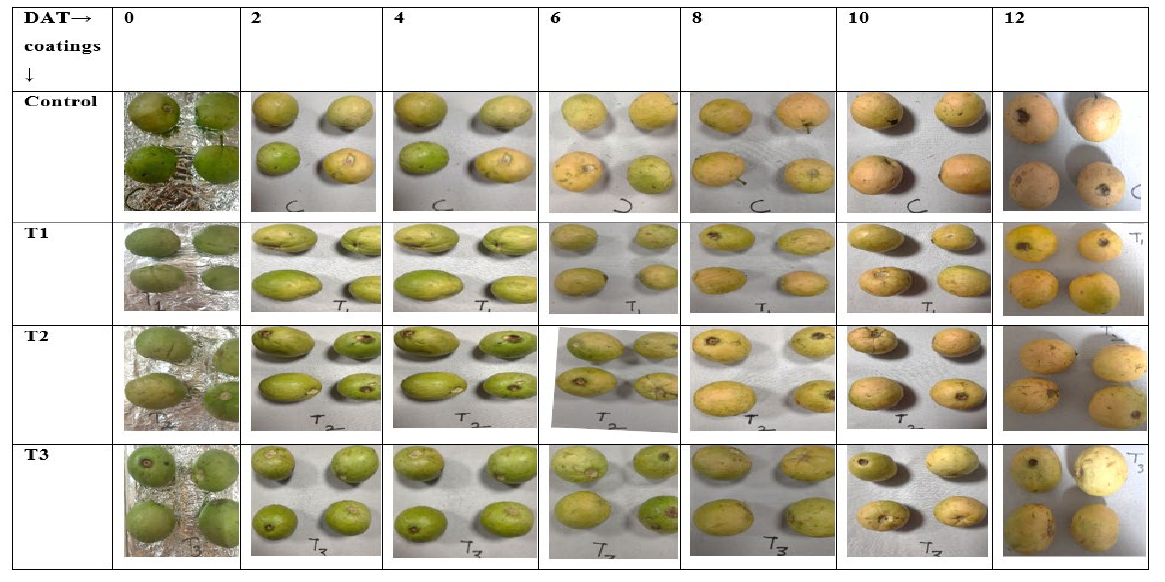
Figure 7. Effect of nanoformulations on color change of guava fruits (Hisar Surkha) during storage at 25 ± 2 °C.